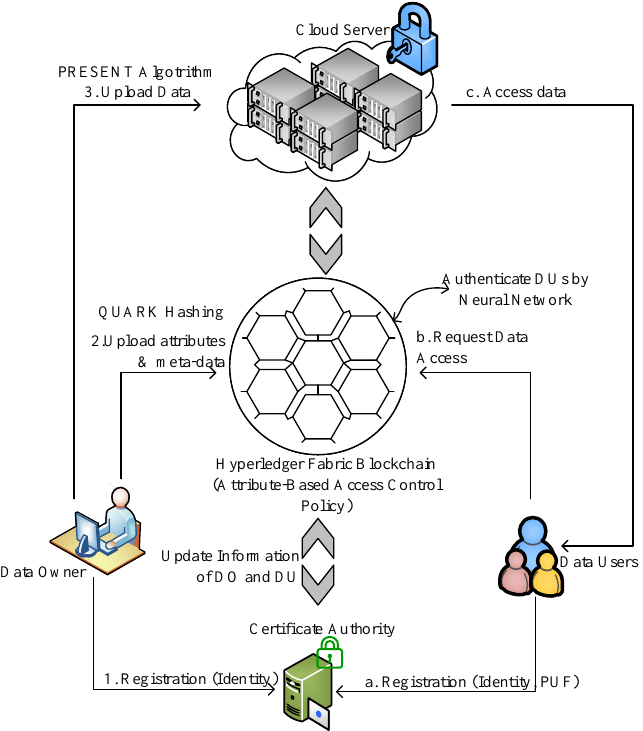
Figure 2. The Proposed AAC-IoT system